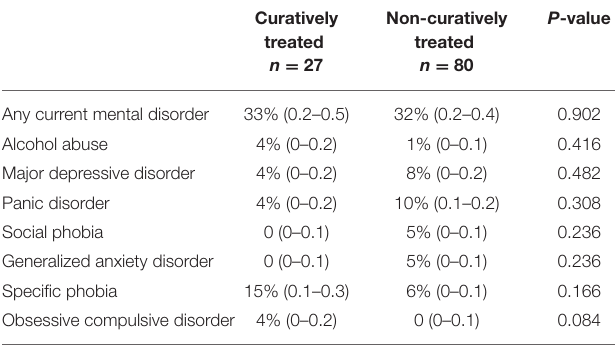
TABLE 2B | Prevalence of current mental disorders in curatively treated in comparison to non-curatively treated CTEPH